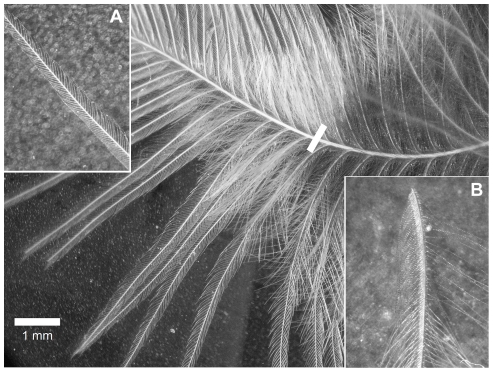
Structure of a great tit contour feather.Illustration of the different parts of a contour feather from the sternal tract of a great tit. The pennaceous barbs on the upper portion and plumulaceous barbs on the lower portion of the rachis are delimited by a white stripe. Details of the pennaceous (A) and plumulaceous barbs (B) with their corresponding barbules are shown as insets.